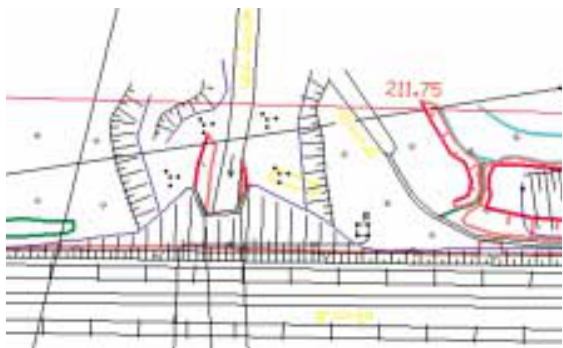
Fig 2. Fragment of data after photogrammetric update